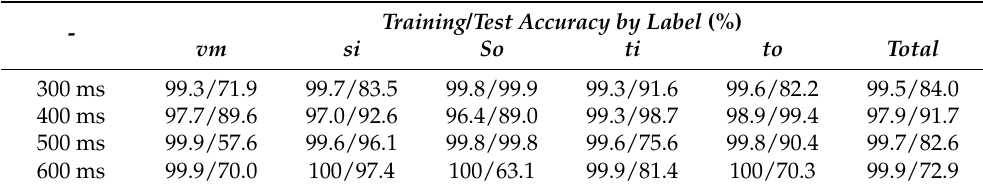
Table 2. Comparison of training and test accuracy of bi-directional LSTM model for the floating body-fixed frame method according to the change in time-horizon length.